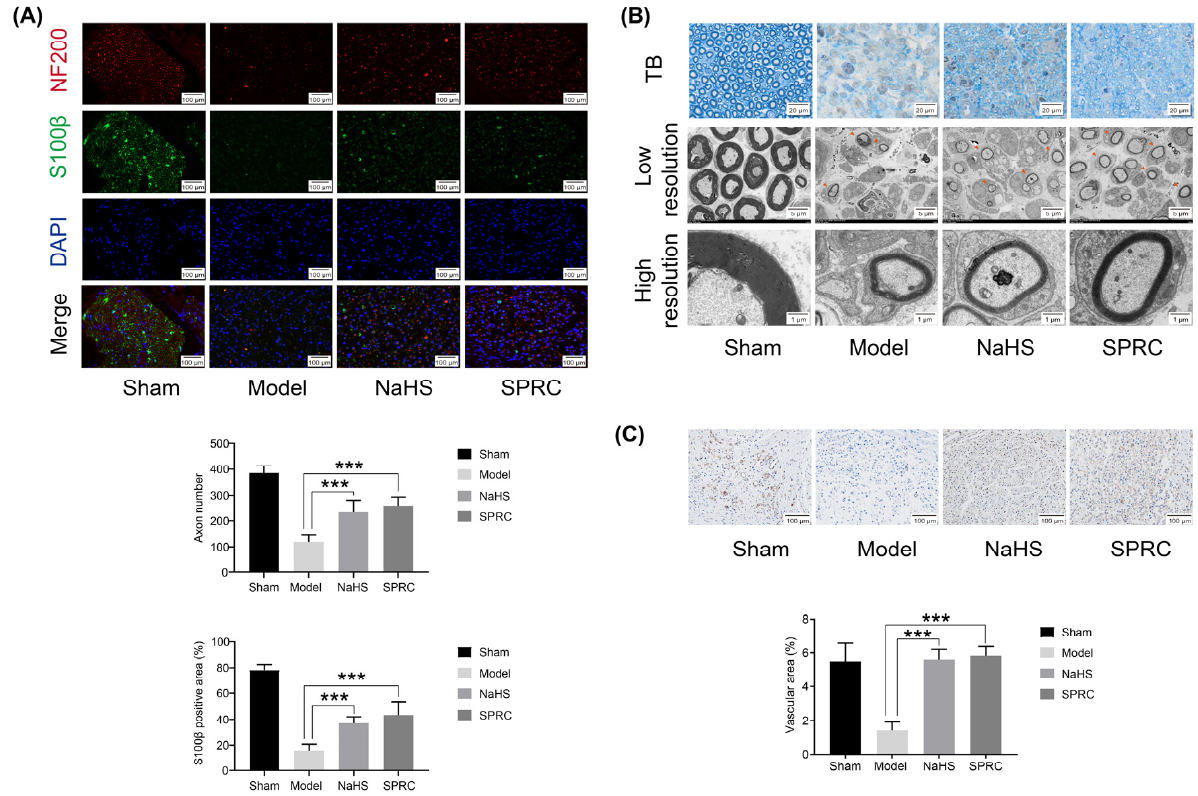
Figure 2. Axon regeneration, Schwann cells (SCs) viability and angiogenesis assessments in rats at 2 weeks after surgery for each group. All images came from the middle cross-sections of the injured nerves. ( A ) Representative images of neurofilament 200 (NF200) and S100 calcium binding beta protein (S100 β ) immunofluorescence staining, and statistical analyses of axon number and S100 β positive area. NF200 (red) indicated the axons, S100 β (green) indicated the SCs, and DAPI (blue) showed the nucleus. ( B ) Toluidine-blue (TB) staining of semi-thin sections and transmission electron microscope (TEM) images of ultra-thin sections. Orange arrows indicated the regenerated axons. ( C ) Representative images of platelet endothelial cell adhesion molecule (PECAM-1/CD31) immunohistochemistry staining and statistical analysis of the vascular area. Data were presented as mean ± SEM ( n = 5 rats). *** p < 0.001 vs. model group.